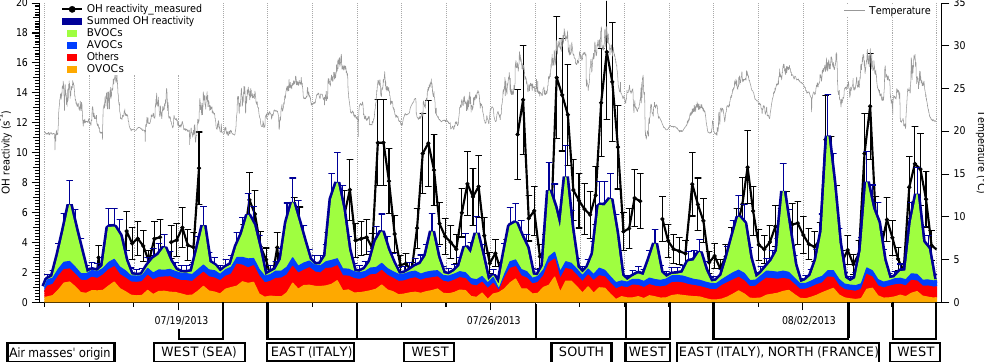
Figure 2. Three-hour averaged data of total OH reactivity measured and calculated from the measured gases. Summed OH reactivity is represented with the blue thick line and grouped as biogenic VOCs in green, anthropogenic VOCs in blue, oxygenated VOCs in orange and others in red. Others refer to carbon monoxide (CO) and nitrogen oxides (NO x